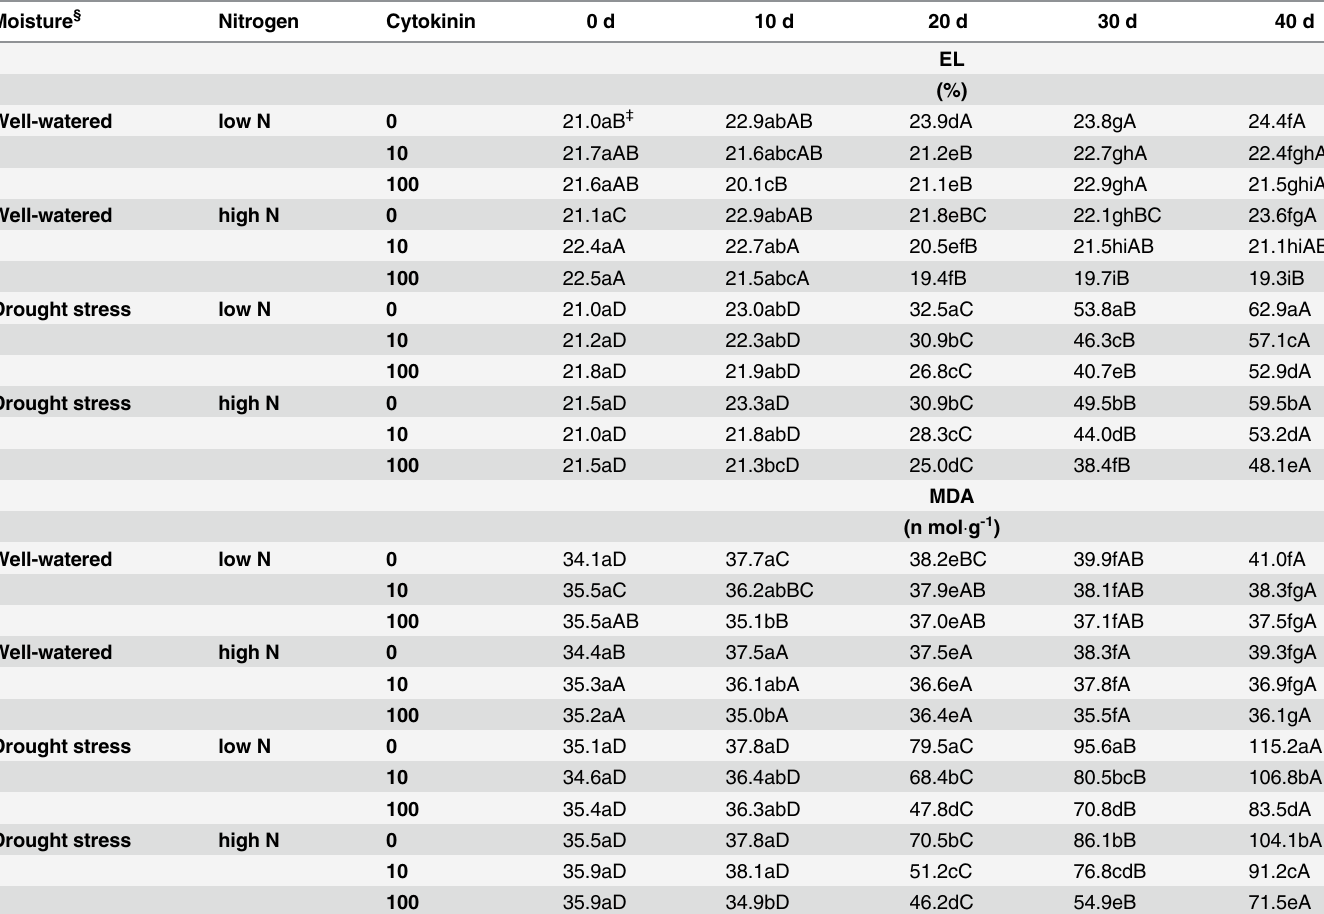
Table 2. Cytokinin and nitrogen impact on leaf electrolyte leakage (EL) and malondialdehyde (MDA) content of creeping bentgrass subjected to two moisture regimes. Moisture §